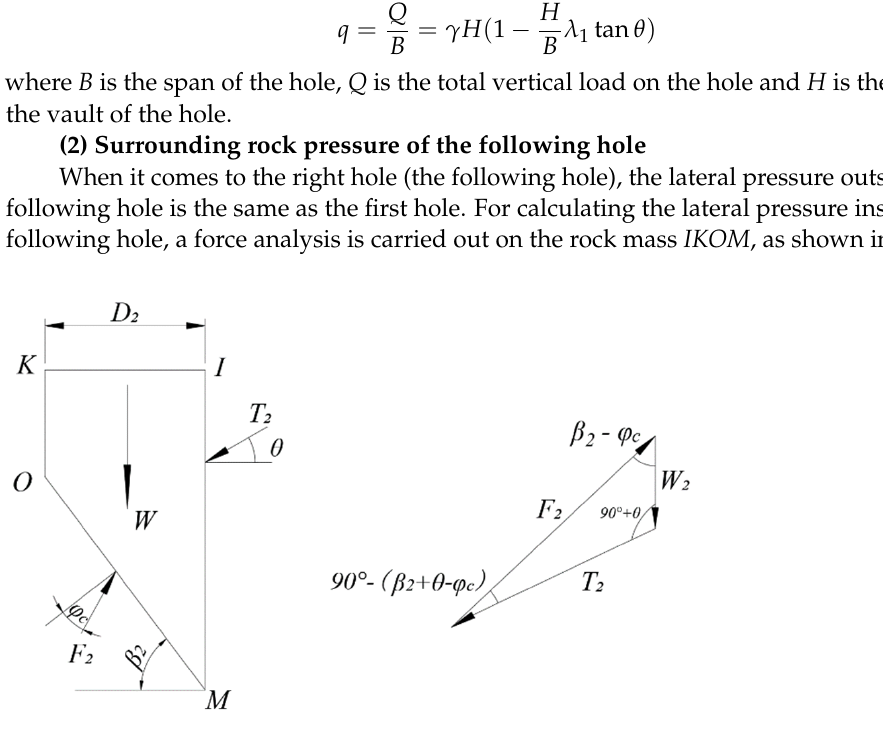
Figure 9. Theoretical sliding failure mode and calculating load schematic diagram. Figure 9. The force analysis of rock mass IKOM